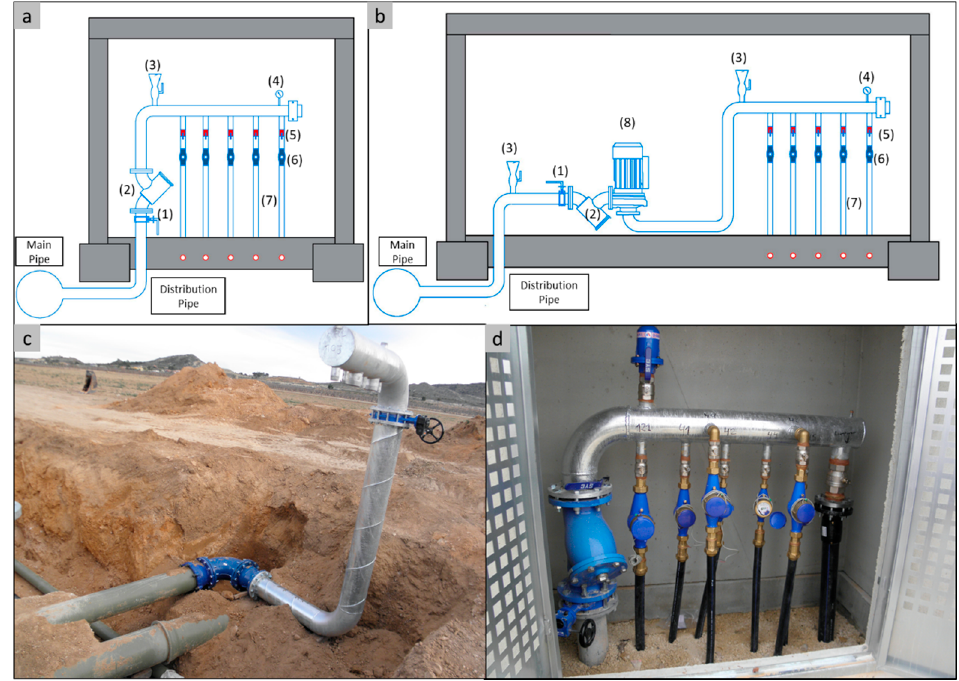
Figure 1. Example of an irrigation hydrant. ( a ) Scheme without hydropower system; ( b ) Scheme with hydropower system; ( c ) Example of connection; ( d ) General view of irrigation hydrant.